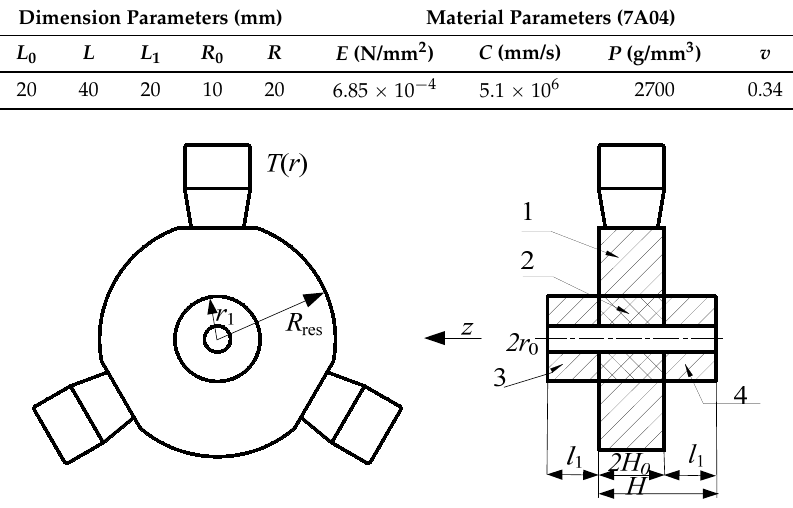
Figure 1. Structure of the composite power-superimposed vibrator.